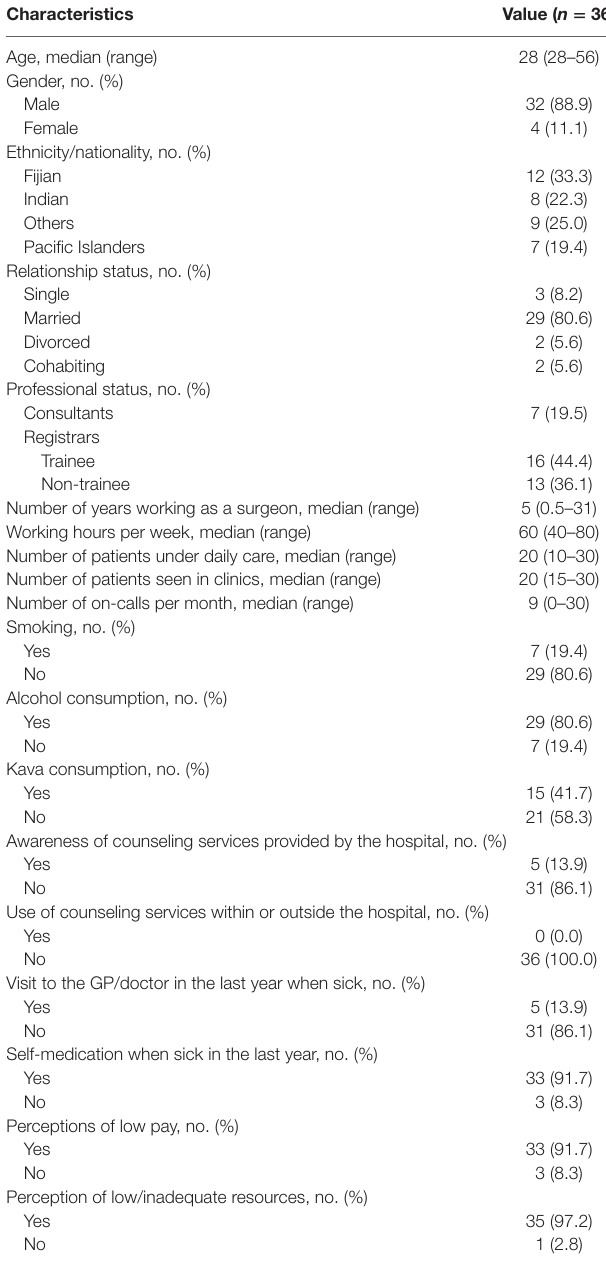
TaBle 1 | respondents’ characteristics.